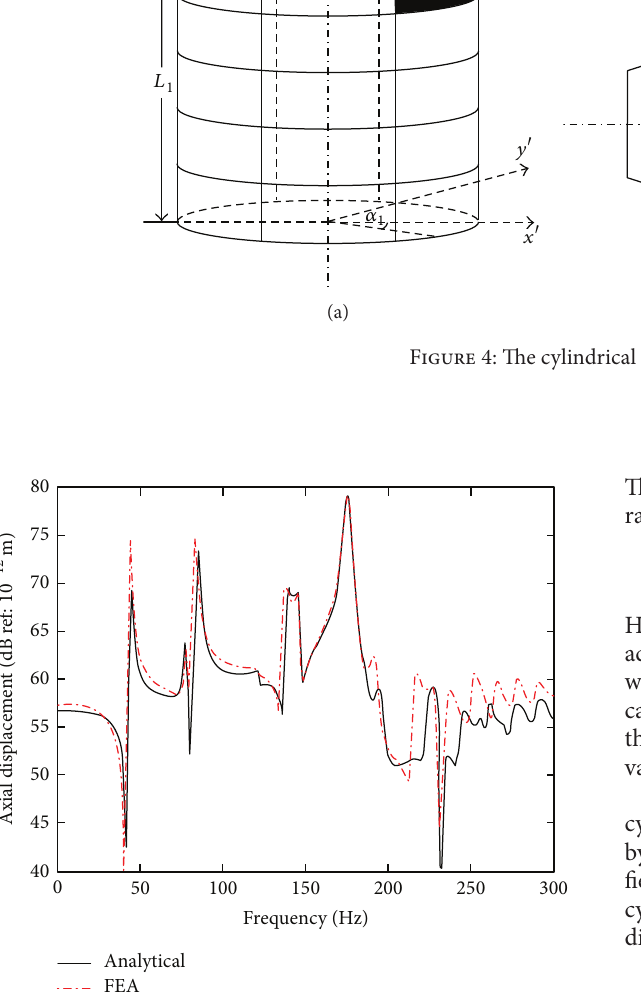
Figure 5: Range of validity for the stiffeners smeared over the conical